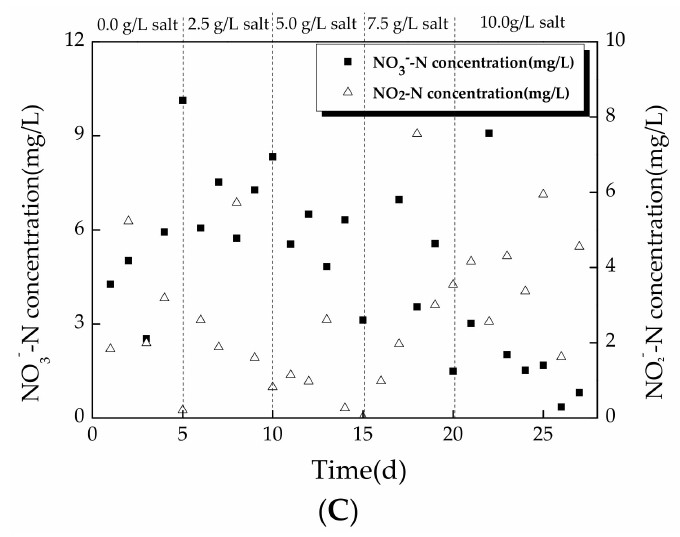
Figure 4. Removal of nitrogen at varying salinity: the effluent concentration and removal efficiency of TN and NH 4 + -N, respectively ( A , B ); and the effluent concentration of NO 3 − -N and NO 2 − -N ( C